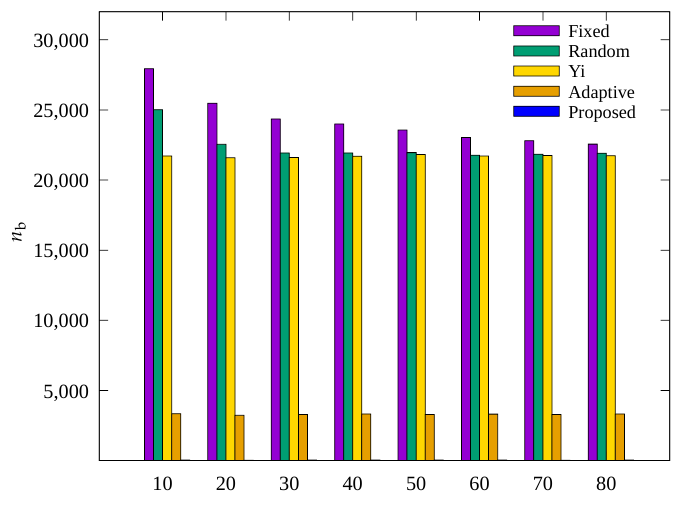
Figure 8. Change in the total number of blackout nodes according to number of